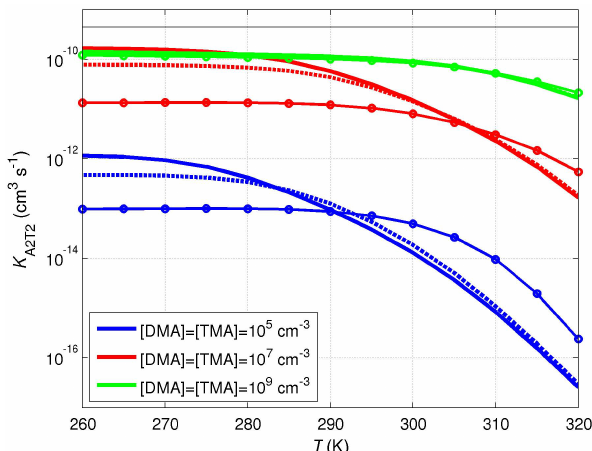
Fig. 7. The modelled coefficient K A2T2 as a function of tempera- ture assuming that the A 2 T 2 and A 2 D 1 T 1 -clusters are grown out of the model when colliding with organic vapour molecules at con- centration of 10 9 cm − 3 . The solid lines correspond to total H 2 SO 4 monomer concentration [A 1 , tot ] = 10 6 cm − 3 , the dashed to [A 1 , tot ] = 10 7 cm − 3 and the solid lines with circles to [A = 10 8 cm − 3 1 , tot ]